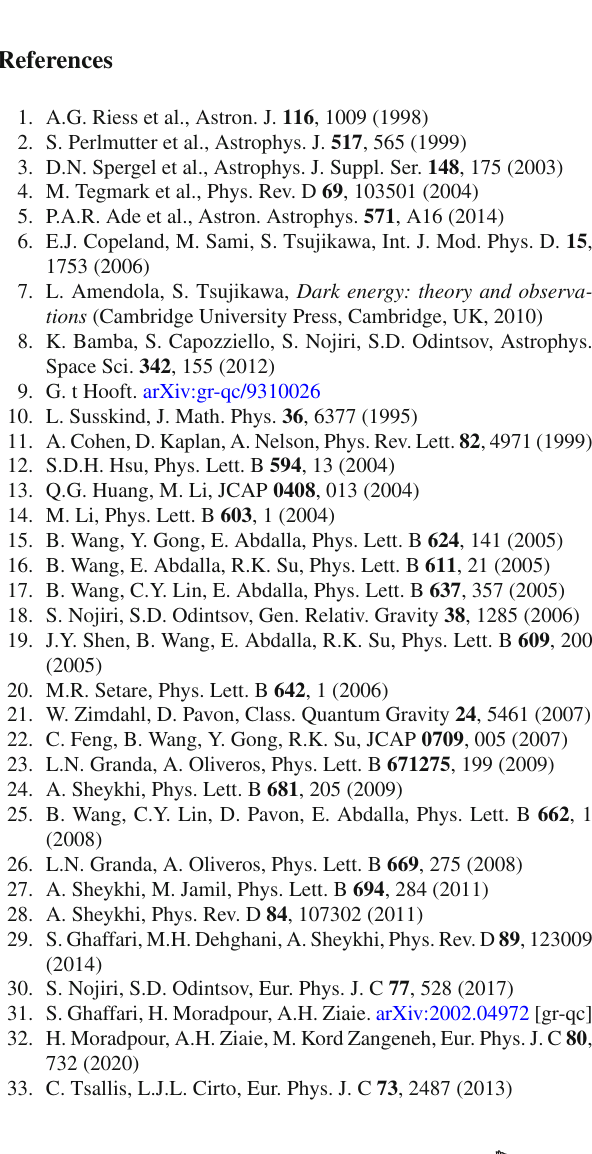
deceleration parameter with present day observational